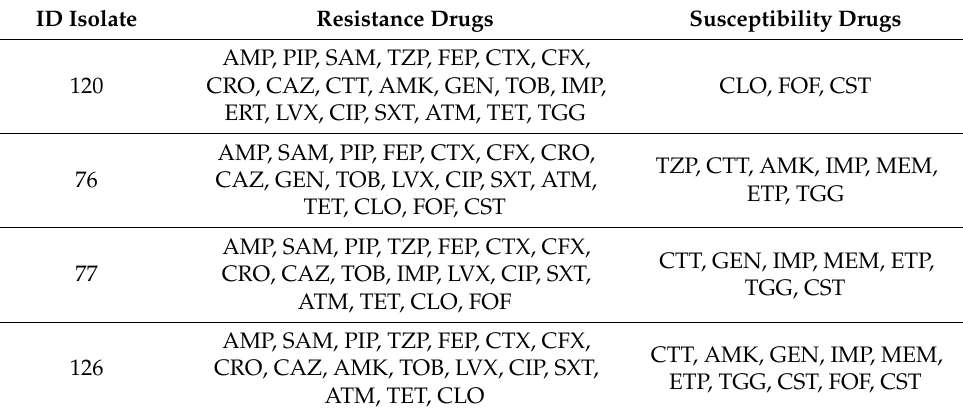
Table 3. Resistance and susceptibility profile of MDR UPEC clinical isolates with highest resis- tance rates.